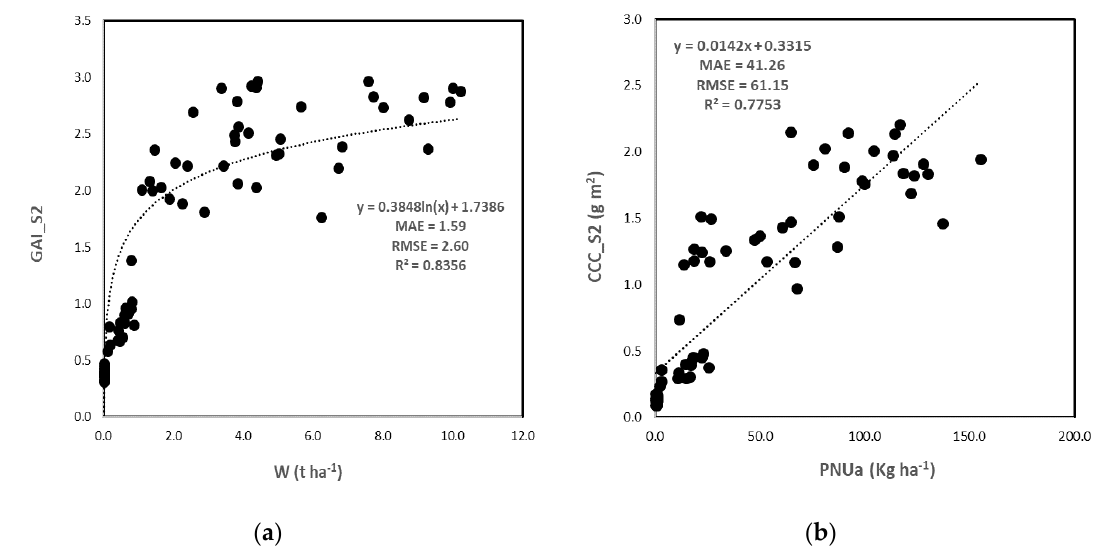
Figure 8. Relationships between biophysical variables retrieved from Sentinel-2 (4 S2 images) and ground measured in maize crop 2018; ( a ) above ground biomass (W) and green area index from S2 (GAI_S2); ( b ) nitrogen uptake (PNUa) and canopy chlorophyll content from S2 (CCC_S2).